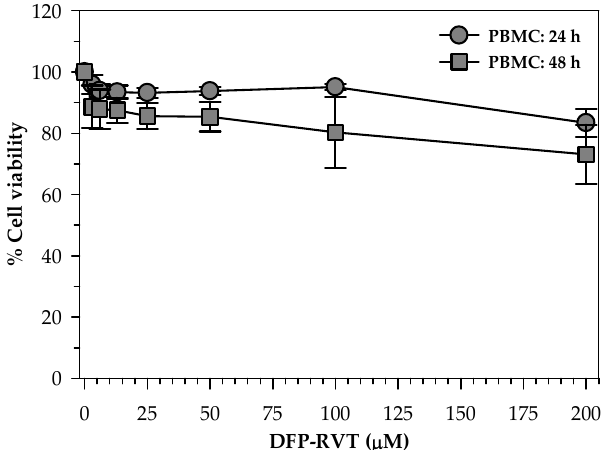
Figure 3. Percent viability of healthy human PBMCs treated with DFP-RVT for 24 and 48 h. Data obtained from three independent triplicate experiments are expressed as mean ± SD values .